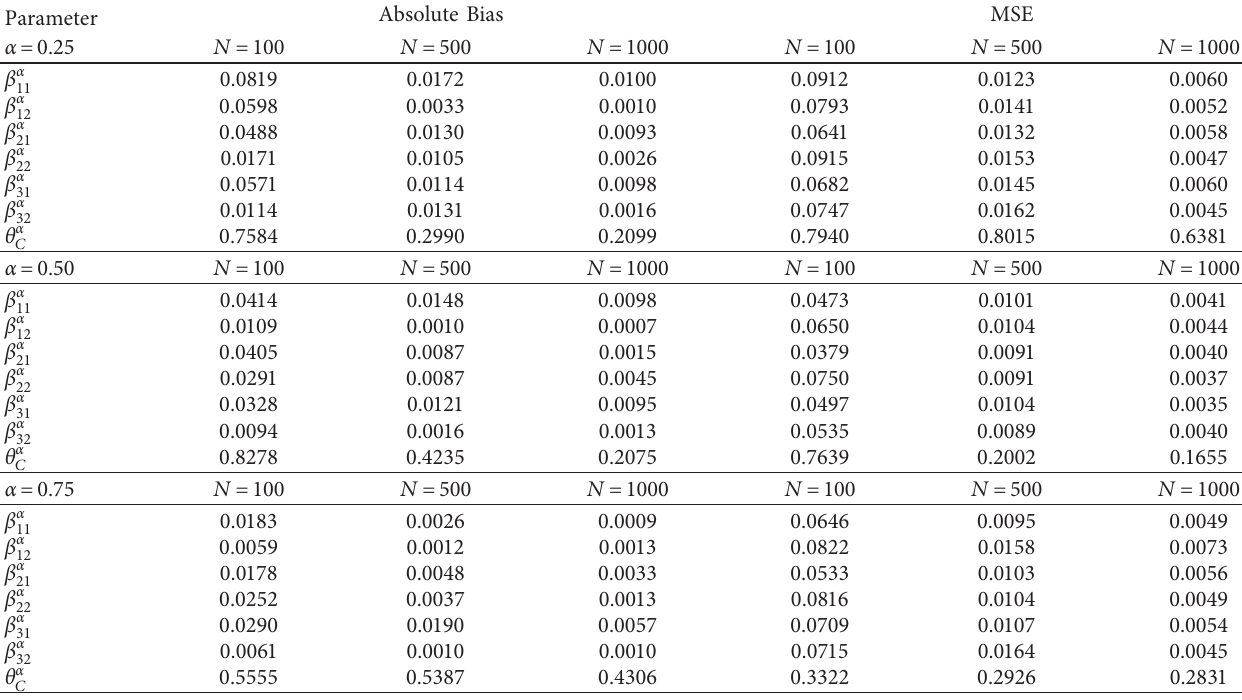
Table 5: Absolute Bias and MSE of parameter estimates from the Bayesian estimation of the Clayton copula with different sample sizes.